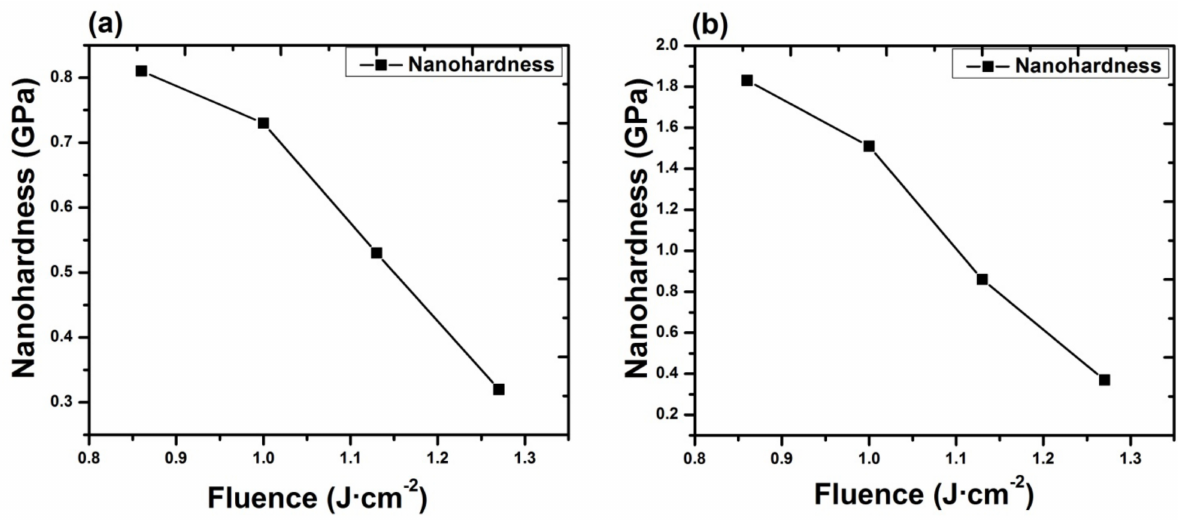
Figure 12. The variation in nanohardness of laser-irradiated Al exposed to 100 pulses of ns laser, at different fluences ranging from 0.86 to 1.27 J · cm − 2 , ( a ) under Ar, ( b ) under O 2 environment at 100 torr pressure. The measurement error (standard deviation) was about ± 0.03 for each